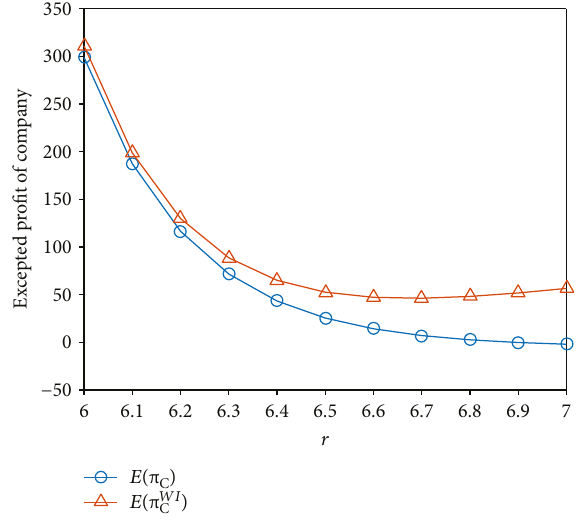
Figure 9: Pro fi t of the company before and after the implementation of WI , φ , T .